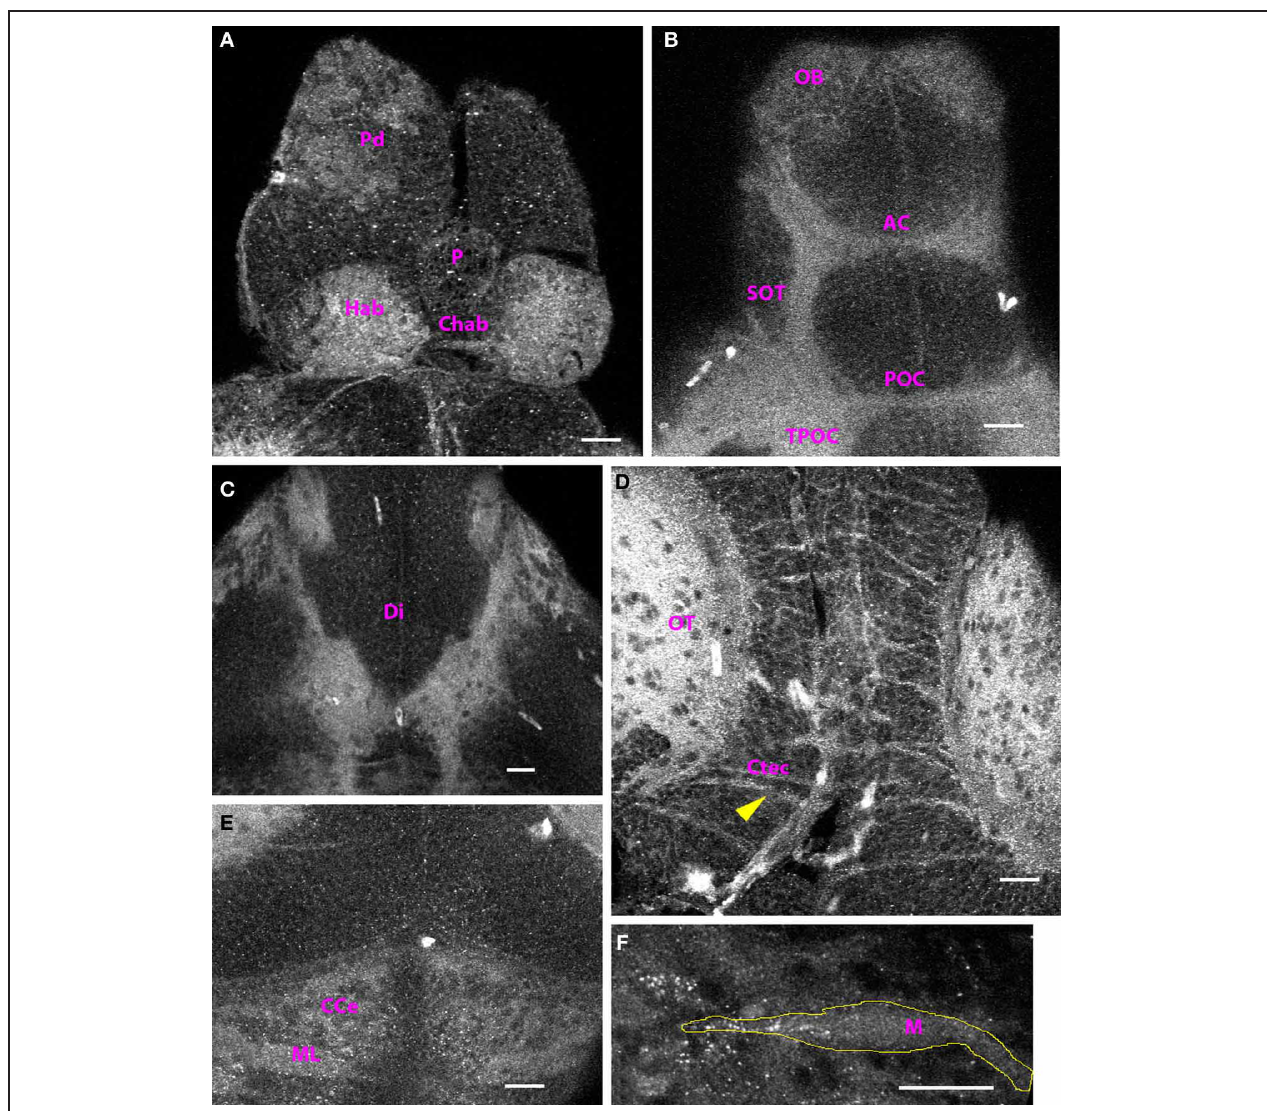
FIGURE 4 | Cx35 immunostaining in 4dpf larvae. Larvae are dorso-ventrally placed with anterior on top in all panels. All panels show single optical sections taken at a z-resolution of 0.44 µ m. (A) Dorsal forebrain showing Cx35 staining in the paired habenulae (Hab) and in the habenular commissure (Chab). Cell bodies in dorsal pallium (Pd) continue to stain positive. No staining is seen in the pineal body (P). (B) Ventral telencephalon showing Cx35 immunoreactivity in the olfactory bulb (OB), anterior commissure (AC), supra-optic tract (SOT), post-optic commissure (POC), and the tract of the post-optic commissure (TPOC). (C) Cx35